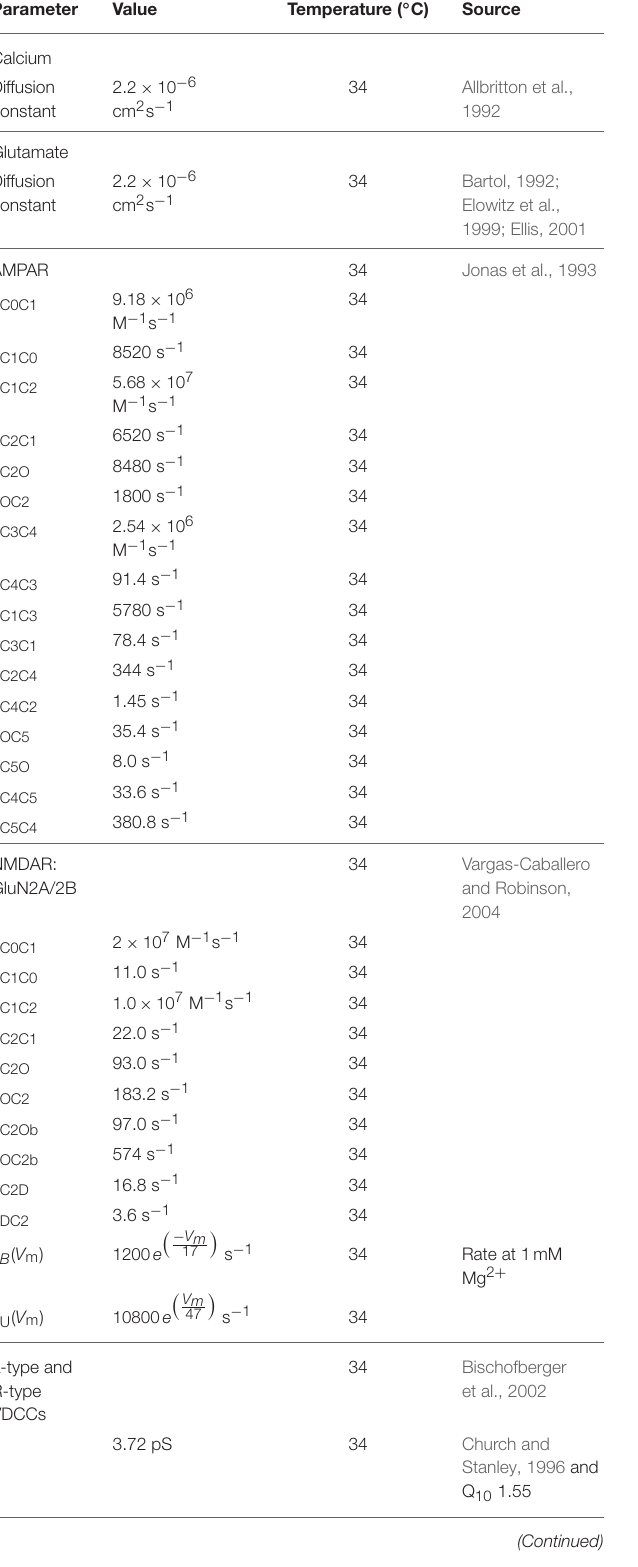
TABLE 1 | Chemical kinetic rates and diffusion constants of molecules in model. Parameter Value Temperature ( ◦ C) Source Calcium Diffusion constant